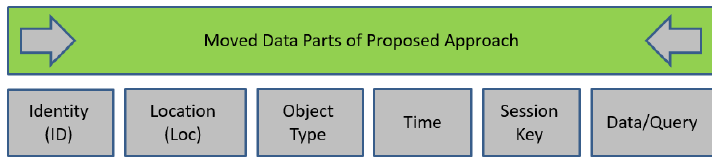
Figure 7. Parts of generic query in Blind